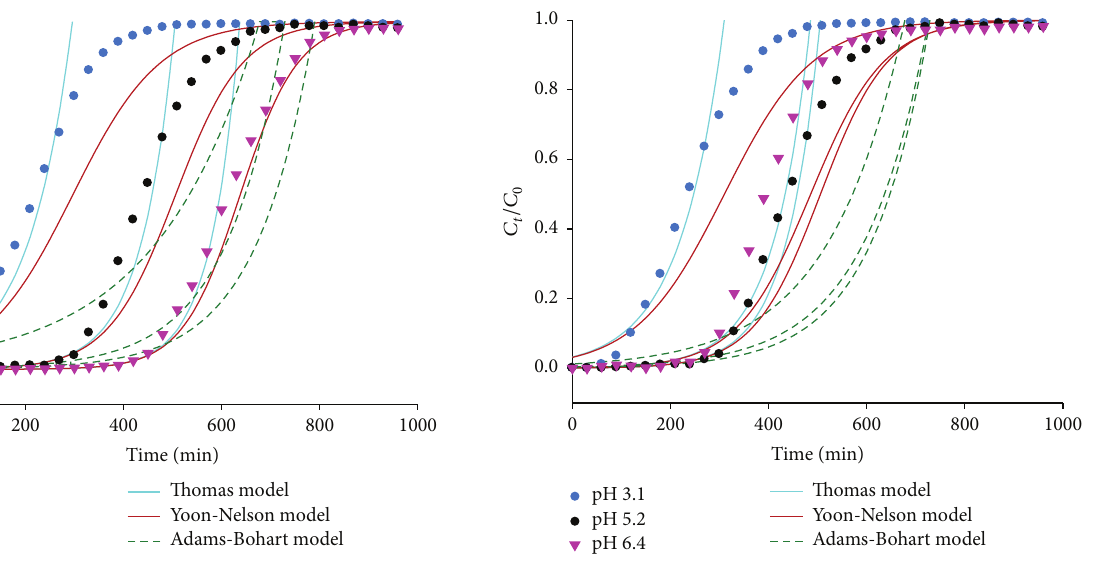
Figure 10: Effect of pH on breakthrough curve (bed depth 5 cm; concentration 20mg/L; flow rates